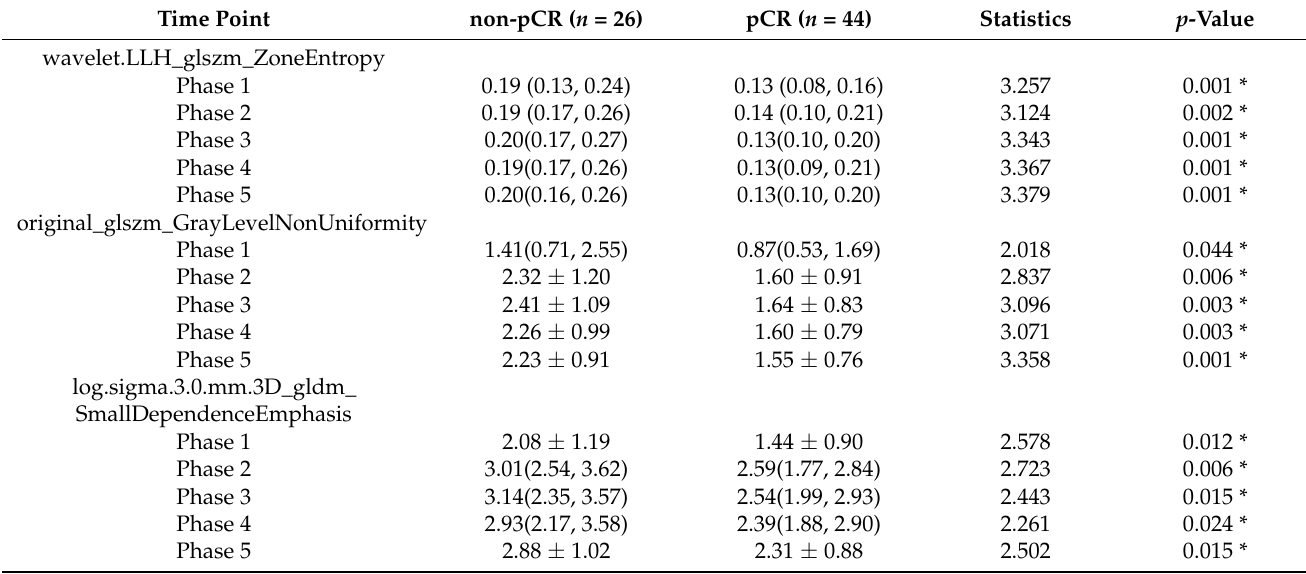
Table 4. The selected ∆ features in the non-pCR and pCR groups at each time